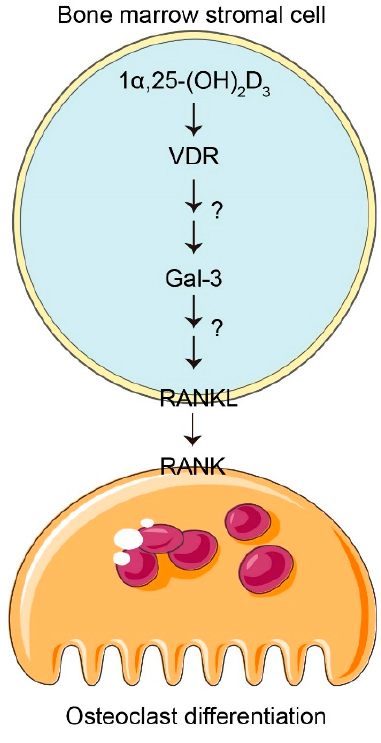
Figure 7. Schematic diagram showing the mechanism of Gal-3 in 1 α ,25(OH) 2 D 3 -regulated differentiation of chicken osteoclasts. Application of 10 − 8 mol/L 1 α ,25(OH) 2 D 3 upregulates Gal-3 expression in BMSC and regulates osteoclast differentiation in the chicken through RANKL signaling.